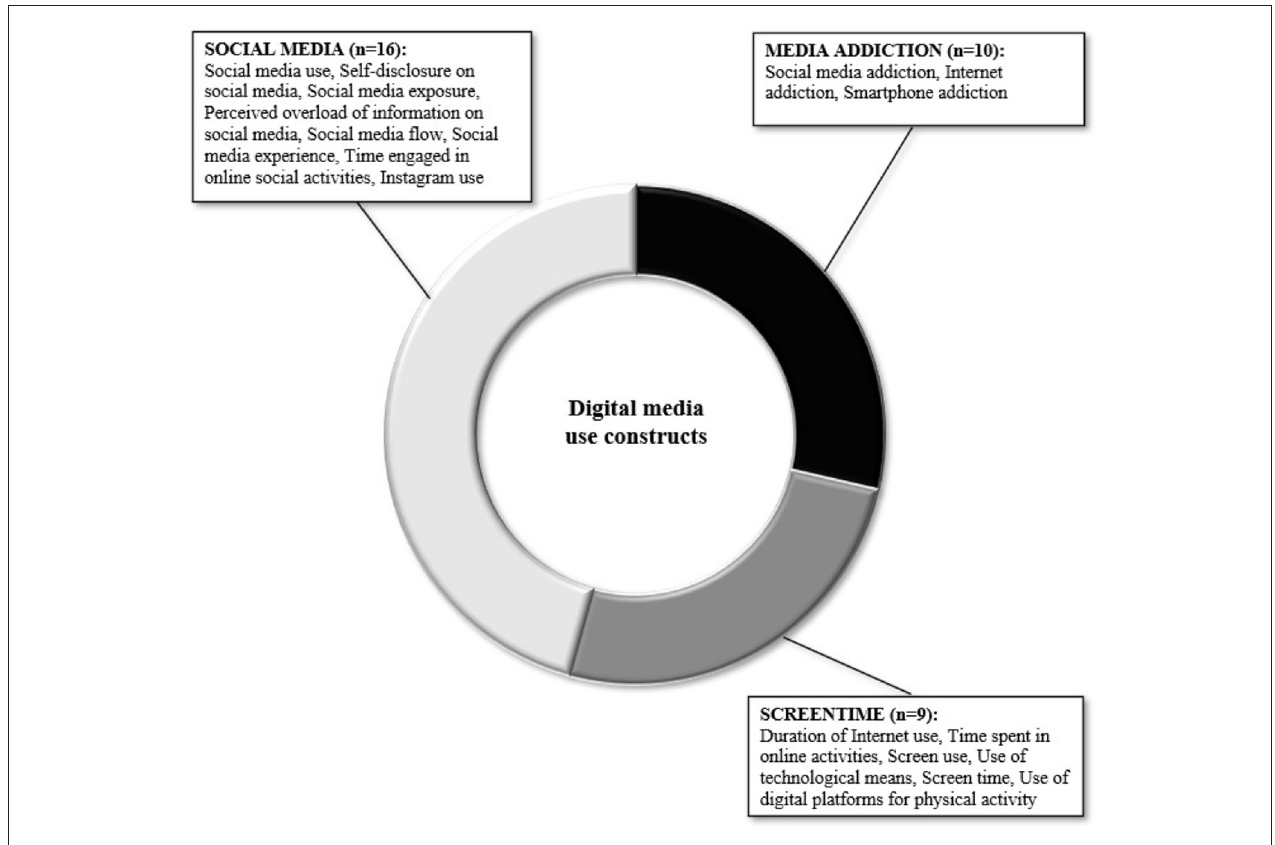
FIGURE 3 | Graphic representation of digital media use investigated